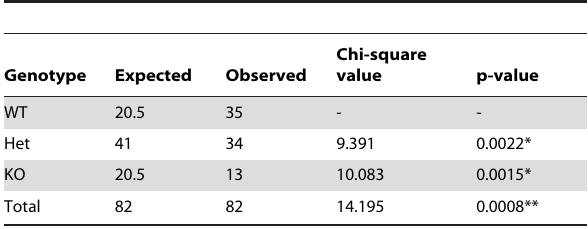
Table 1. Non-Mendelian ratios of pups from heterozygous Btbd9 mutant mice